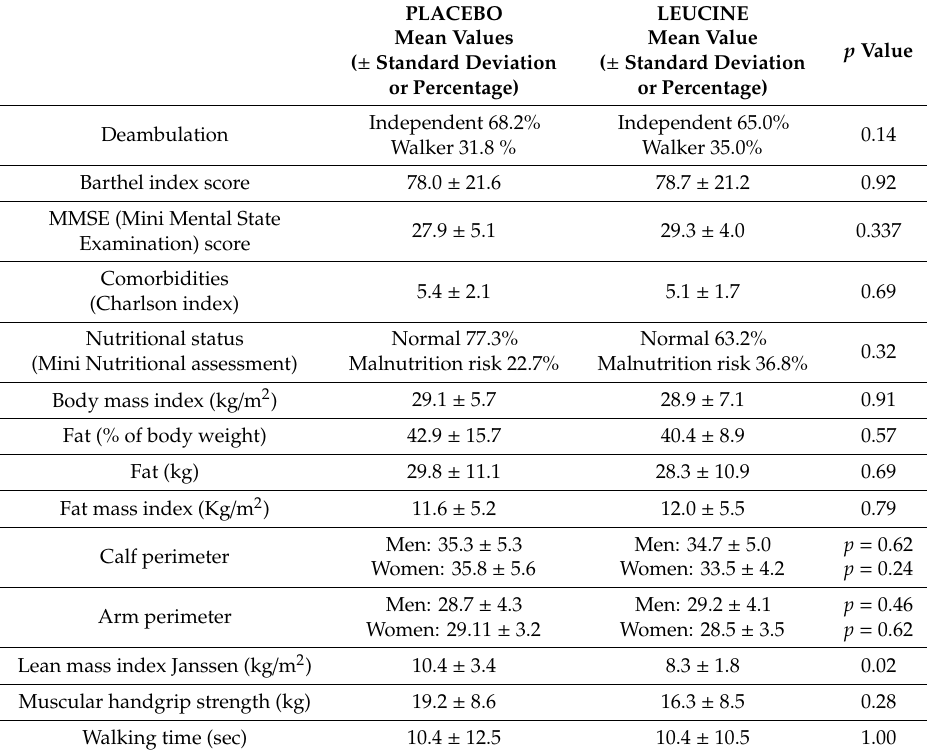
Table 1. Psycho-geriatric baseline characteristics of participants enrolled in the